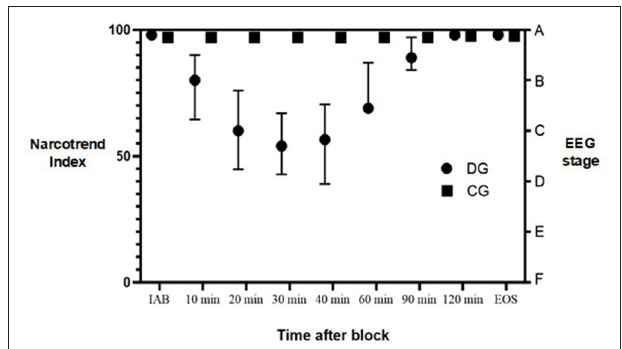
FIGURE 1 | Narcotrend Index during surgery. DG, dexmedetomidine group; CG, control group; IAB, initially after block; EOS, end of surgery; EEG, electroencephalography. Dots represent median values. Lines represent interquartile